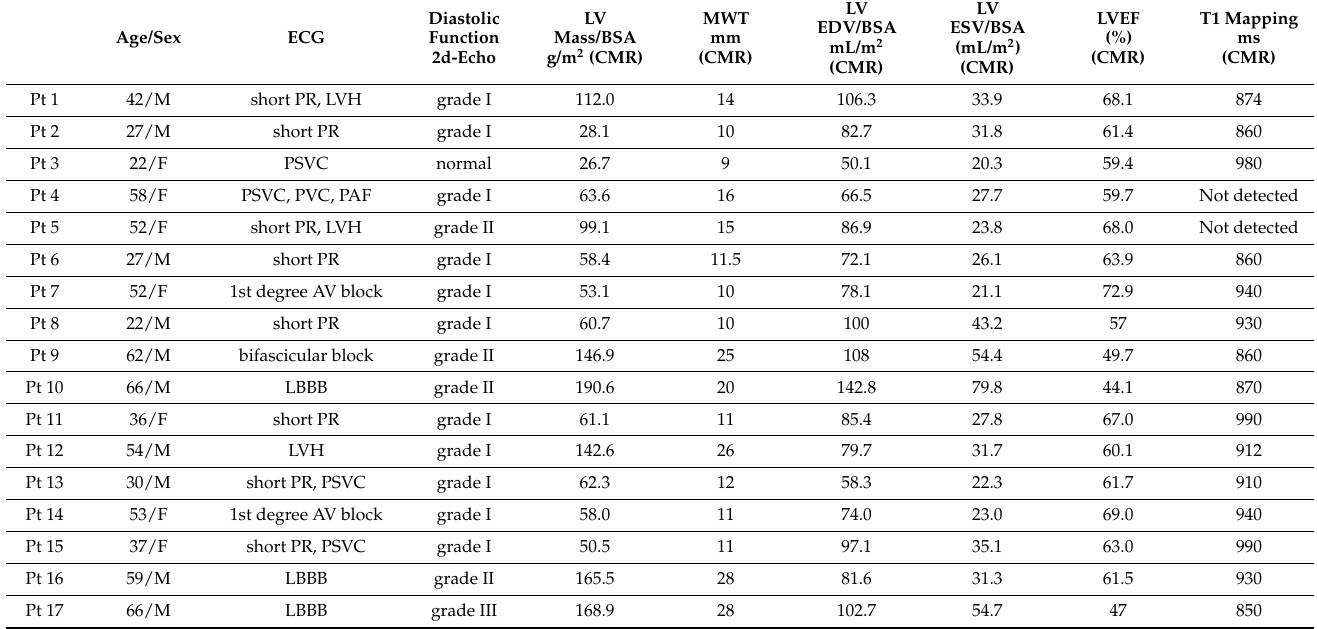
Table 2. Baseline instrumental features of patient